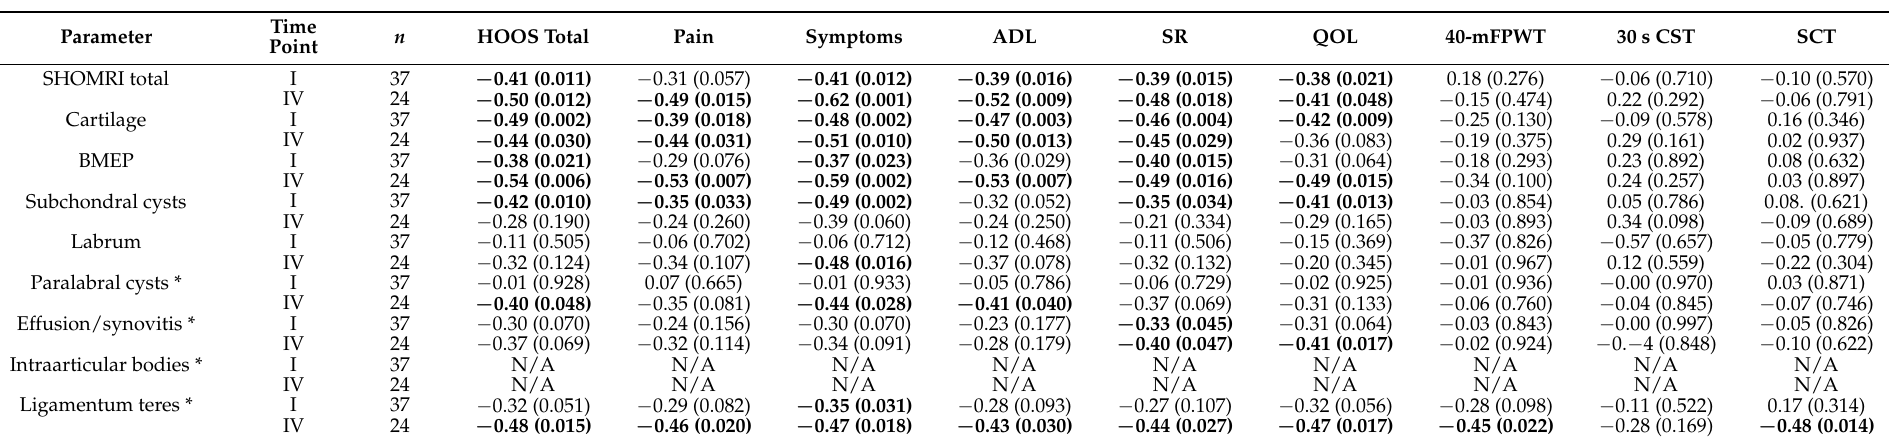
Table 6. Correlation analysis among symptomatic hip MRI and functional parameters at baseline and 12-month